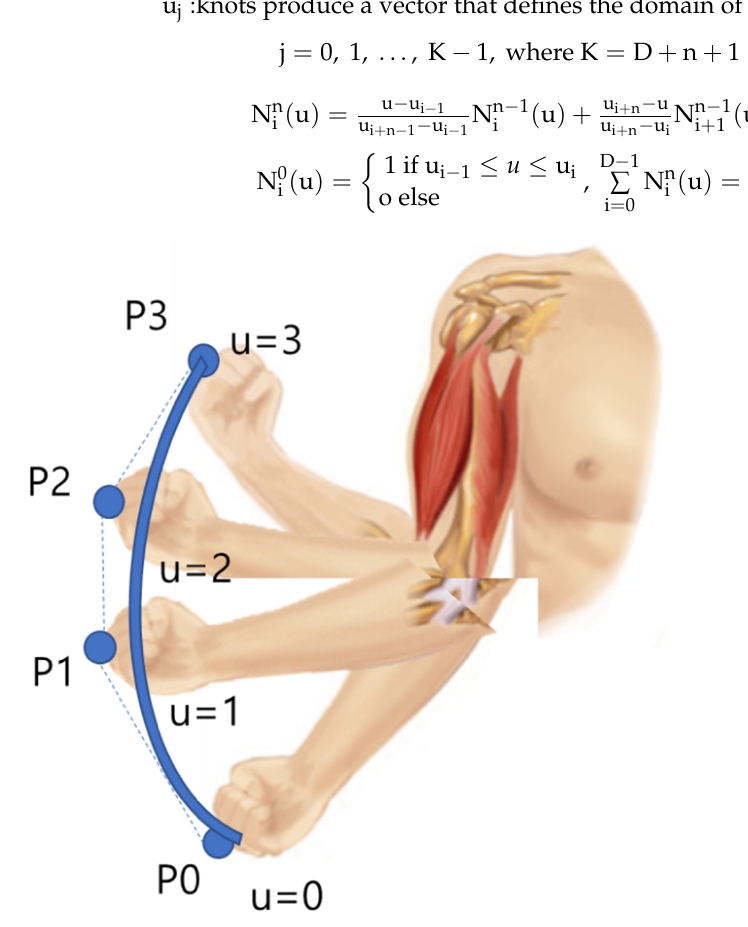
Figure 4. Example of the generation of movement